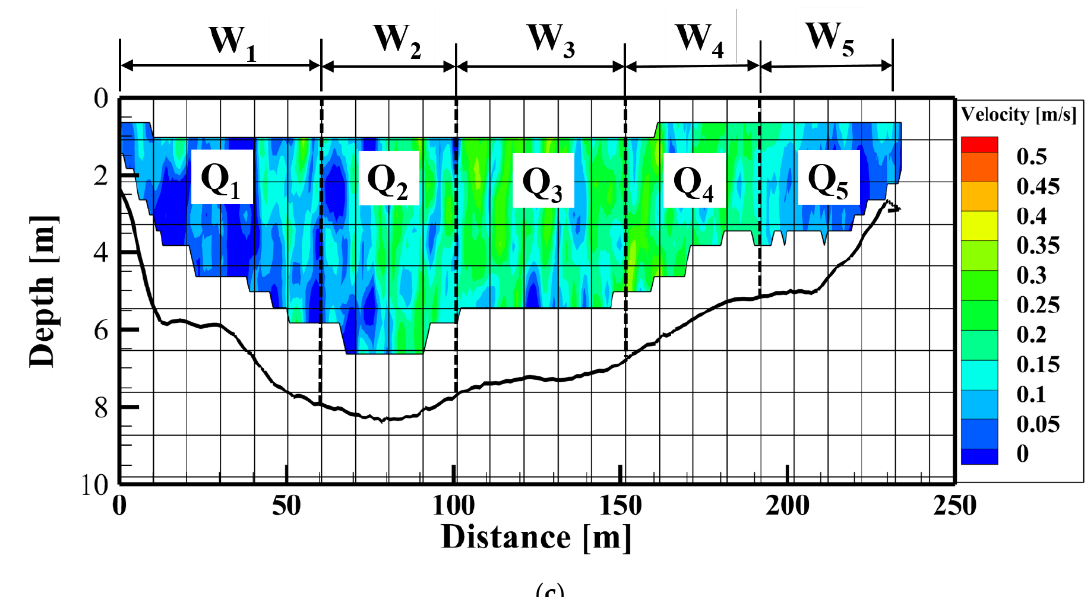
Figure 5. Estimating procedures for total suspended load from measurement using LISST-100X. ( a ) Measured water velocity by ADCP, ( b ) two-dimensional (2D) distribution results from the measured SSC by LISST-100X, and ( c ) 2D distribution outcome based on the EDI method used for the estimation of total suspended sediment load.